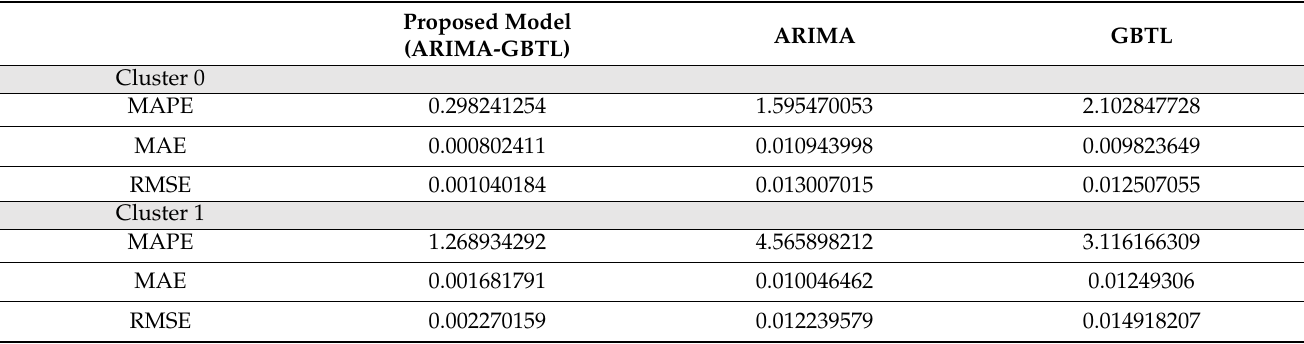
Table 8. The Model